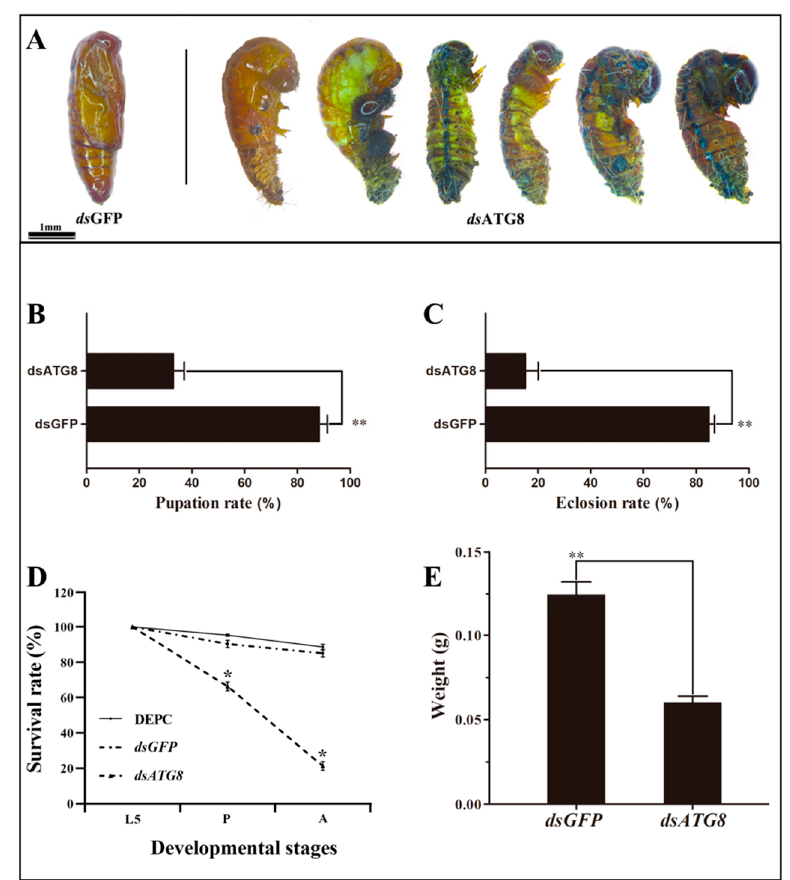
Figure 6. E ff ects of HvATG8 RNAi on larval-to-pupal and pupal-to-adult transition rate. ( A ) Lethal phenotypes caused by HvATG8 silencing. ( B ) Pupation rate after ds HvATG8 and ds GFP injections. ( C ) Eclosion rate after ds HvATG8 and ds GFP injections. ( D ) Survival changes in H . vitessoides after ds HvATG8 injections at 96 h after injections (* p < 0.05, using Kaplan–Meier survival analysis with the log-rank test). ( E ) Larval weight at 72 h after ds HvATG8 and ds GFP injections. These data were recorded separately based on a sample size of 150 larvae. Error bars represent mean ± standard error of three biological replicates. * p < 0.05, ** p < 0.01 based on Students’ t-test.